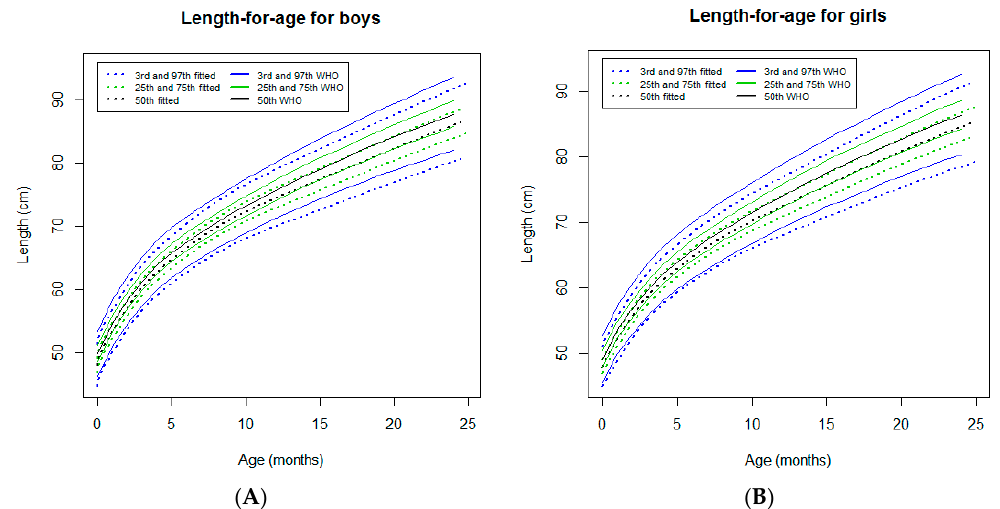
Figure 3. Comparison of the WHO Child Growth Standards (solid lines) with smoothed centile curves (dotted lines) of measured length-for-age for boys ( A ) and girls ( B ) from the neonatal period to 24 months of age.